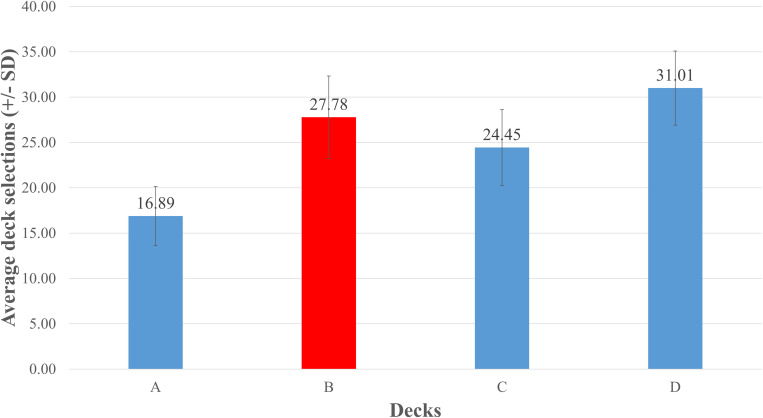
Mean number of card selections in 86 IGT-related studies. The figure was produced by averaging the numbers of the four decks chosen across the 86 IGT-related studies. Selections of deck B were relatively higher than those of decks A and C, demonstrating that the PDB phenomenon was present. This finding is consistent with those obtained in a growing number of other IGT-related researches.